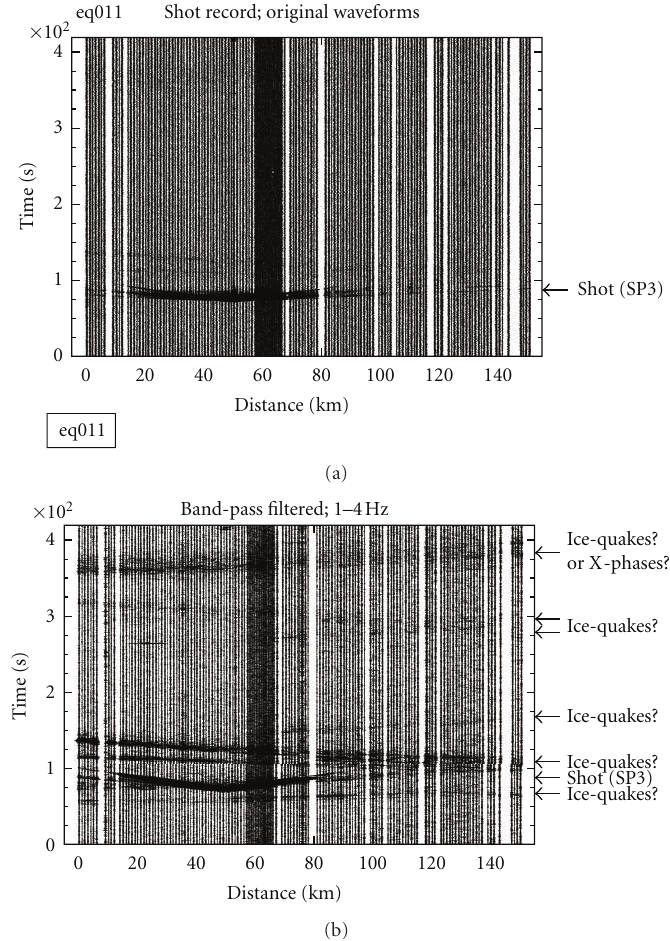
Figure 3: (upper) Original waveforms for record section of artificial active source by SEAL-2002 exploration (shot No. SP3 (2002/01/20/14:01 (UTC)); event#; eq011). (lower) Band-pass filtered (1.0–4.0 Hz) waveforms of the same record section. Many local events which appeared to be the ice-quakes are recognized in the record. Starting time of the vertical axis is 14:00 (UTC) on January 20,